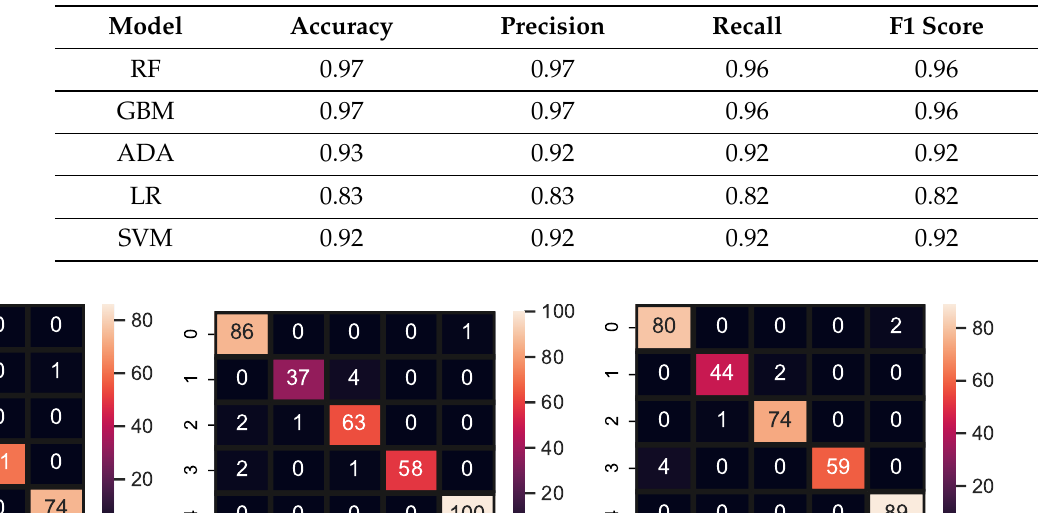
Table 10. Performance of machine learning models using FFS feature set.